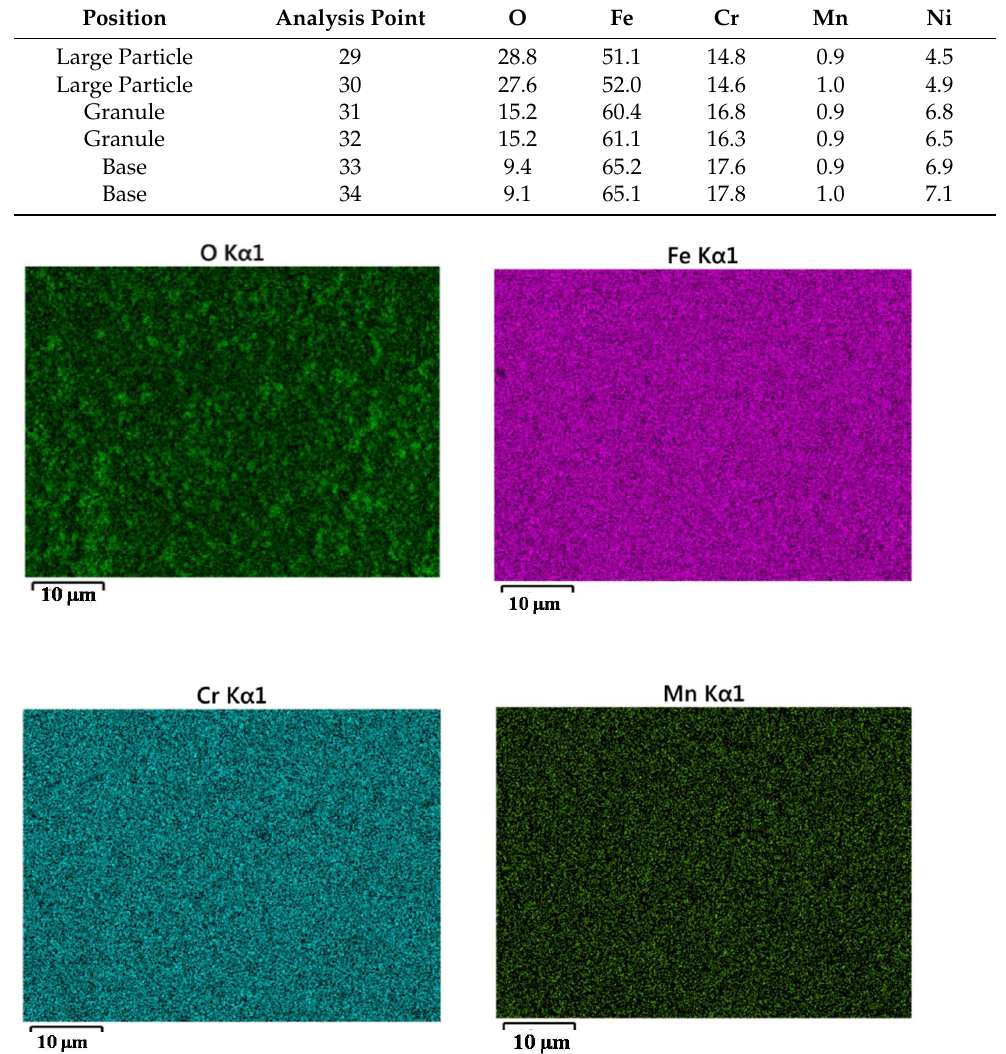
Table 4. Spot scan composition of FeCrMnNi alloy after corrosion in 360 ◦ C high temperature and high pressure water environment for 14 days.